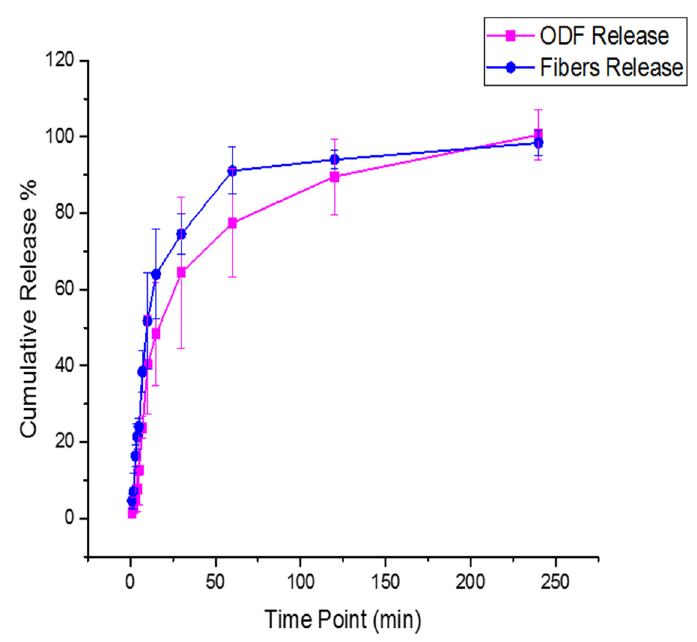
Figure 7. The cumulative release profile of the drug-loaded nanofibers and ODFs, showing a significantly ( p < 0.0001) faster drug release profile of PSP-loaded nanofibers compared to PSP-loaded ODFs after 240 min in SSF (pH 6.8).